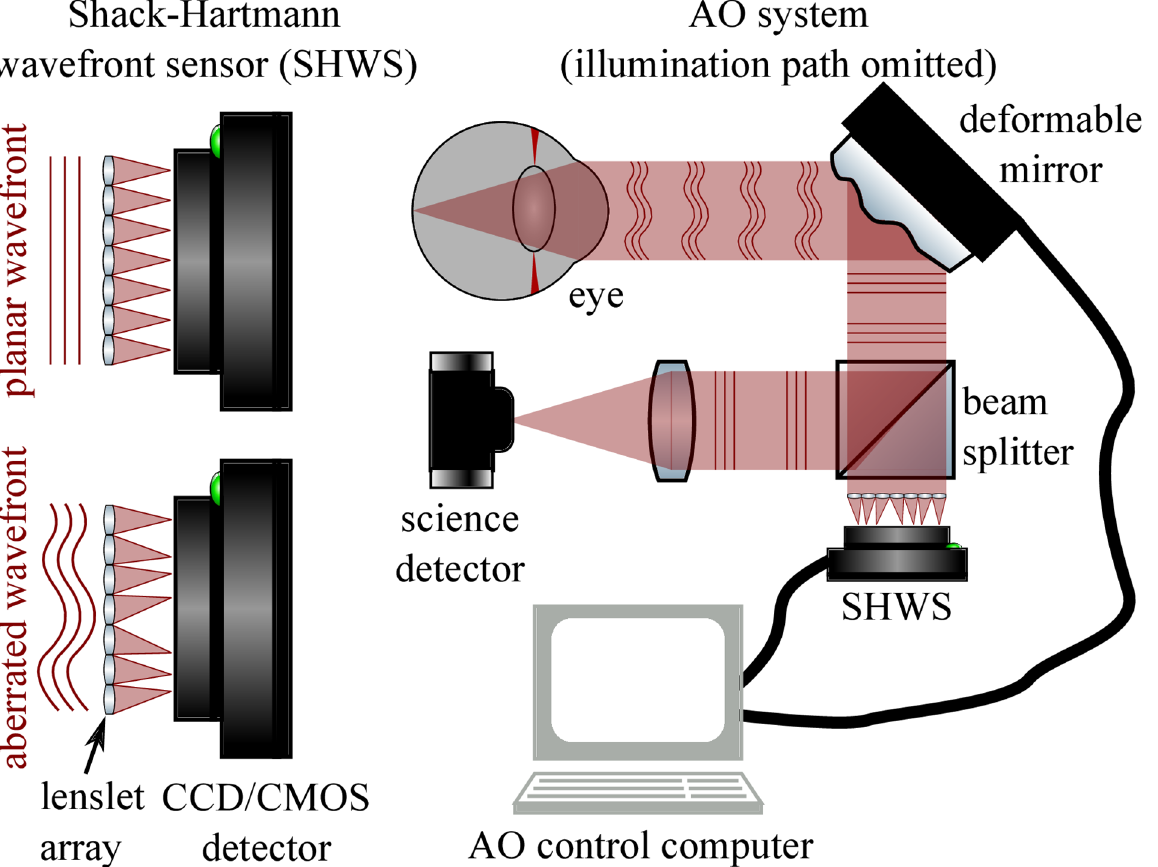
Figure 2. Adaptive optics technology system with Shack–Harmann wavefront sensor (SHWS) and deformable mirror schematic. SHWS utilizes a small lenslet array and samples a wavefront; displacements due to aberrations can drive a corrector (e.g., deformable mirror). This technology can help to visualize individual cells in the human retina [42,45]. Reprinted with permission from Jonnal et al. [45]. A Review of Adaptive Optics Optical Coherence Tomography: Technical Advances, Scientific Applications, and the Future. Invest Ophthalmol. Vis Sci. 2016;57(9):OCT51-68 with license permissions obtained from Creative Commons; Creative Commons Attribution-Non-Commercial-No Derivatives 4.0 International (CC BY-NC-ND 4.0, https://creativecommons.org/licenses/by-nc-nd/4.0/legalcode (accessed on 1 August 2022)).